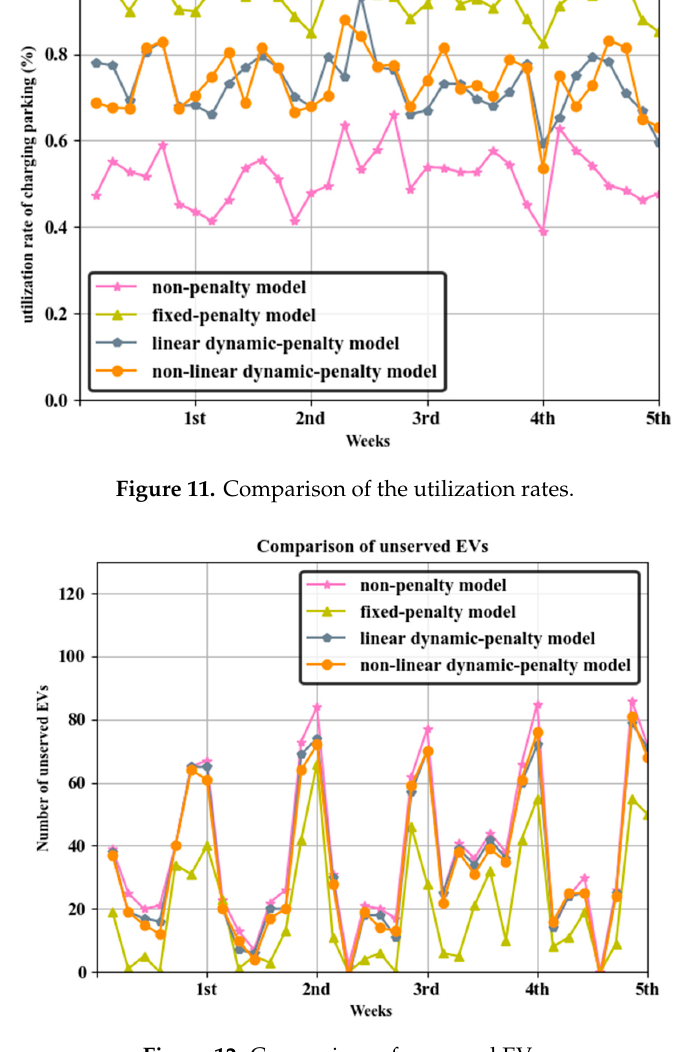
Figure 11. Comparison of the utilization rates.